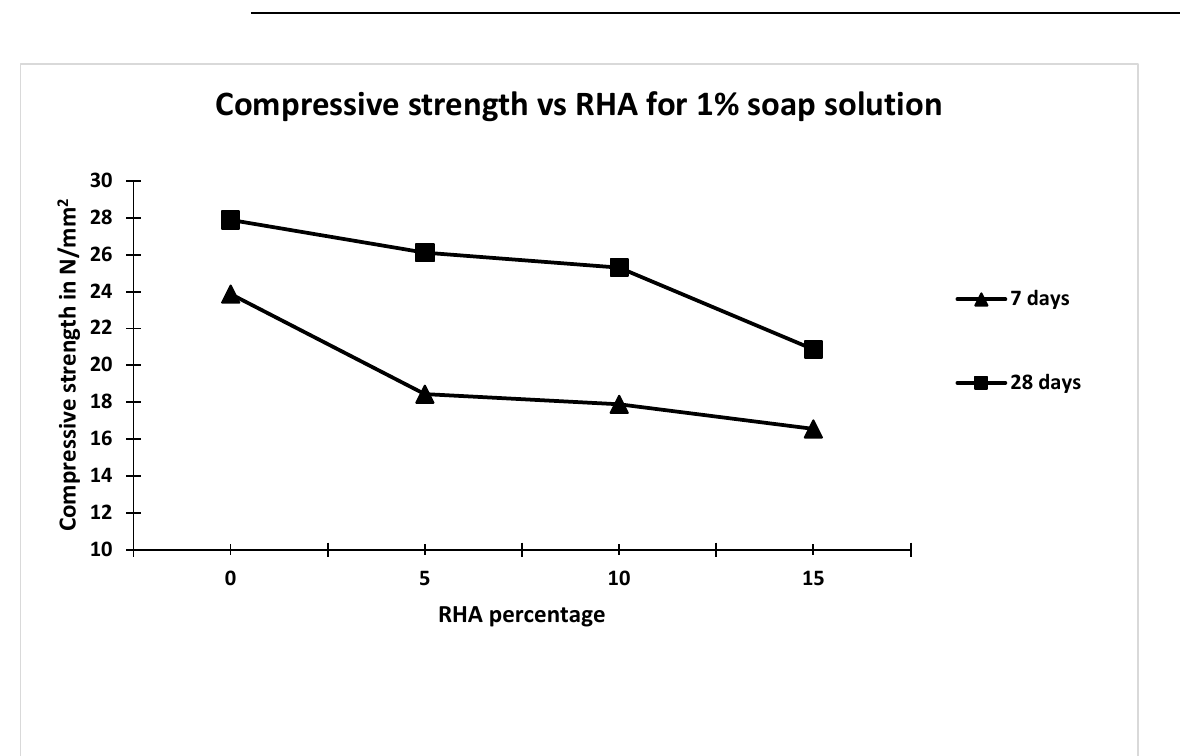
Figure 3. Graph between compressive strength and RHA for 1 % soap solution.